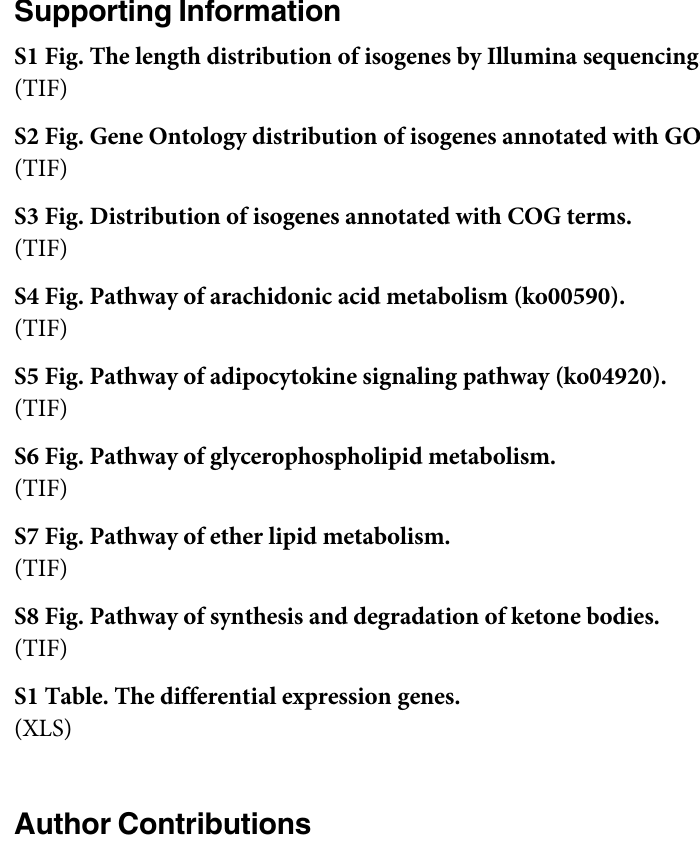
S1 Fig. The length distribution of isogenes by Illumina sequencing. (TIF) S2 Fig. Gene Ontology distribution of isogenes annotated with GO terms. (TIF) S3 Fig. Distribution of isogenes annotated with COG terms. S4 Fig. Pathway of arachidonic acid metabolism (ko00590). S5 Fig. Pathway of adipocytokine signaling pathway (ko04920). S6 Fig. Pathway of glycerophospholipid metabolism. S7 Fig. Pathway of ether lipid metabolism. S8 Fig. Pathway of synthesis and degradation of ketone bodies. S1 Table. The differential expression